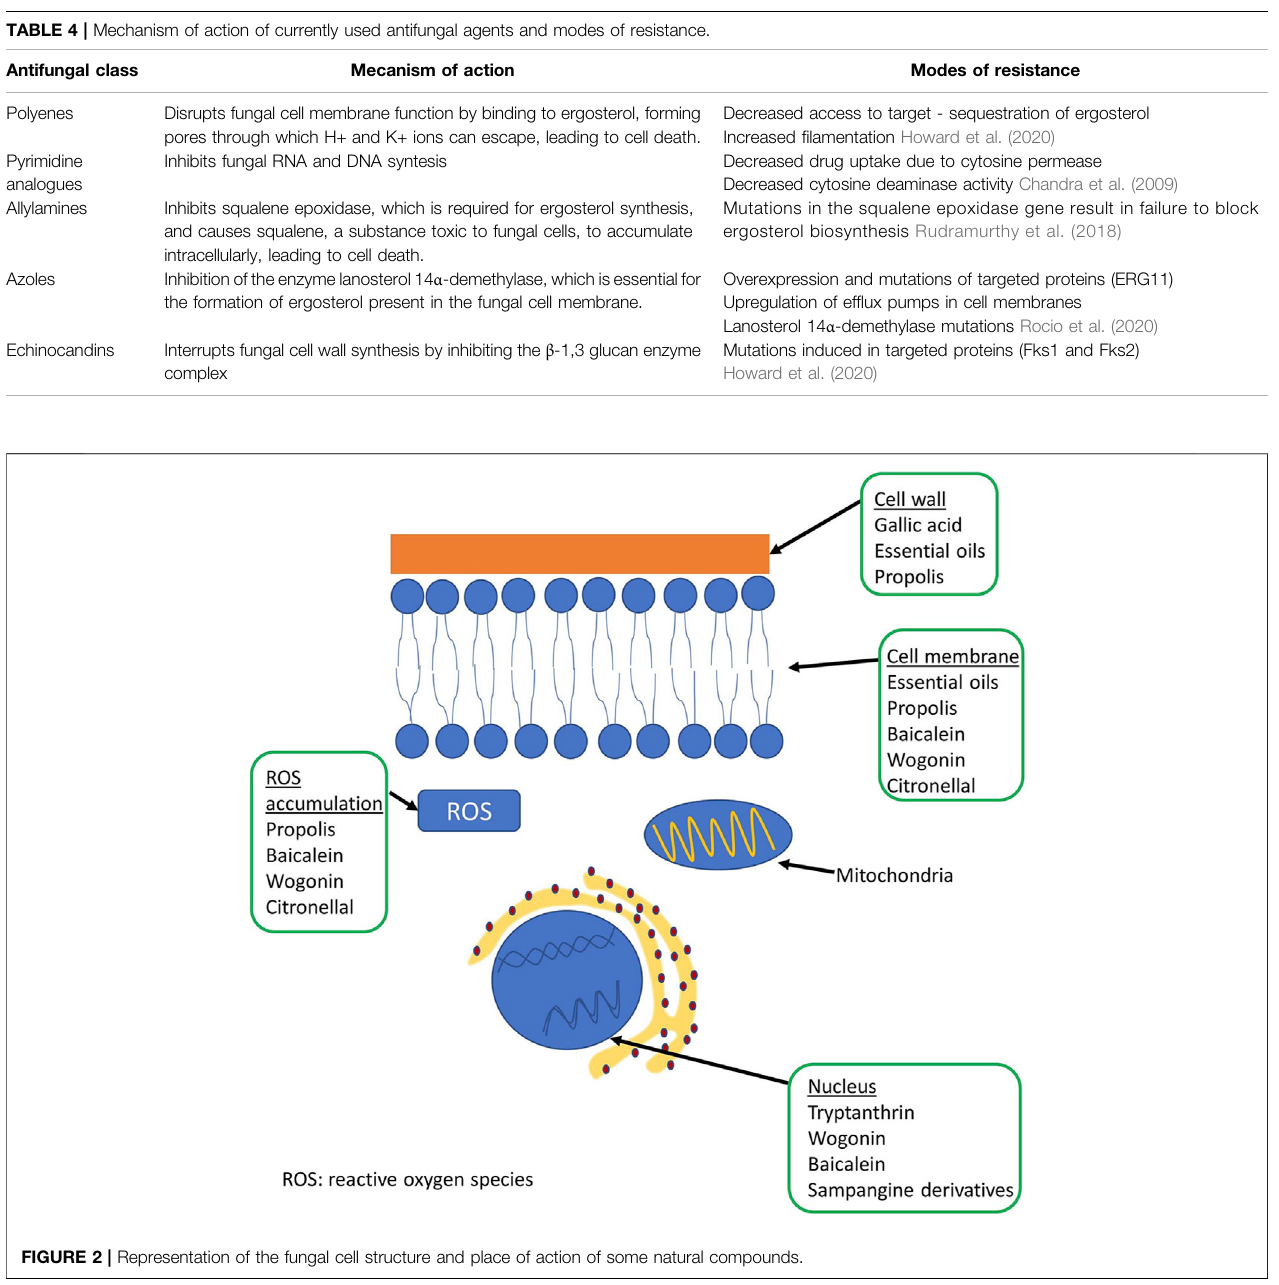
Frontiers in Pharmacology |